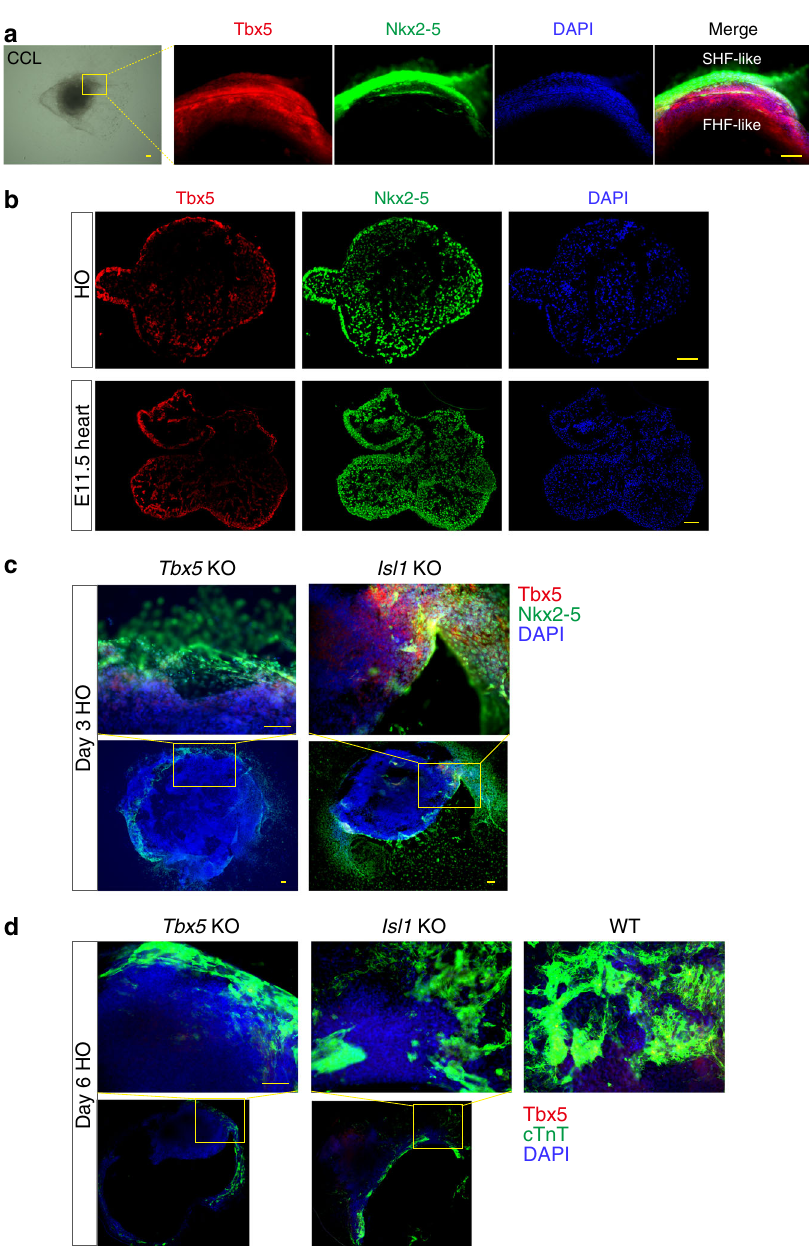
Fig. 4 Expressions of cardiac transcription factors (TFs) and its perturbation in heart organoid (HO)s. a Immuno fl uorescent staining to detect Nkx2-5 (green) and Tbx5 (red) in cardiac-crescent-like structures at day 3 of HO culture ( n = 8, two experiments). Scale bar: 100 μ m. b Immuno fl uorescent staining to detect Nkx2-5 (green) and Tbx5 (red) in HOs was cultured for more than 9 days. The representative HO ( n = 13 out of n = 16) showed expression similar to that in embryonic hearts (E11.5). Scale bar: 100 μ m. c , d Recapitulation of cardiac perturbation during in vitro HO formation from Tbx5 KO- and Isl1 KO-ESCs. c Immuno fl uorescent staining to detect Nkx2-5 (green) and Tbx5 (red) at day 3 of HO culture from derived Tbx5 KO- ( n = 17, left) and Isl1 KO-ESCs ( n = 16, right). In the Tbx5 KO-derived HO, delayed or abnormal morphogenesis was observed with decreased Tbx5 expression and disrupted typical location of Tbx5 and Nkx2-5. In the case of Isl1 KO-derived HOs, the expression of Tbx5 and Nkx2-5 was not clearly separated. Two experiments. Scale bar: 100 μ m. d Immuno fl uorescent staining to detect cTnT (a CM marker, green)/ α SMA (an SM marker, red) at day 6 of HO culture from derived Tbx5 KO- ( n = 16, two experiments), Isl1 KO- ( n = 17), and WT-ESCs ( n = 9). The weak expressions of cTnT and/or α SMA compared to those of control (WT) HOs at day 6. Scale bar: 100 μ